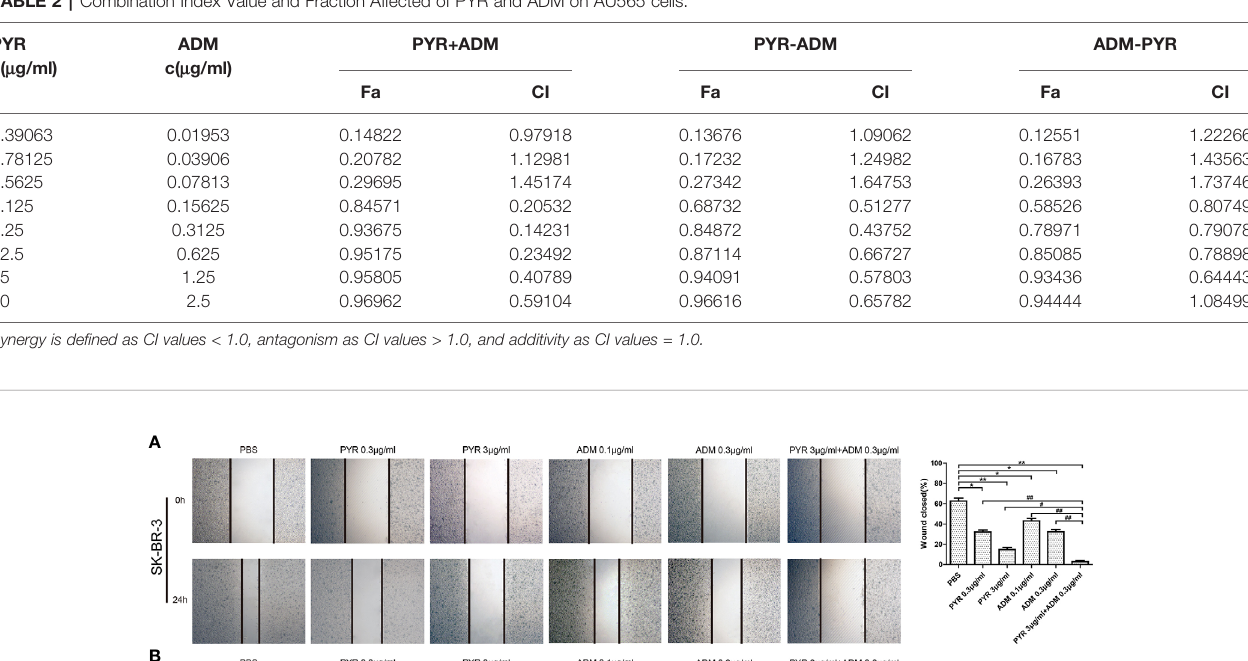
TABLE 2 | Combination Index Value and Fraction Affected of PYR and ADM on AU565